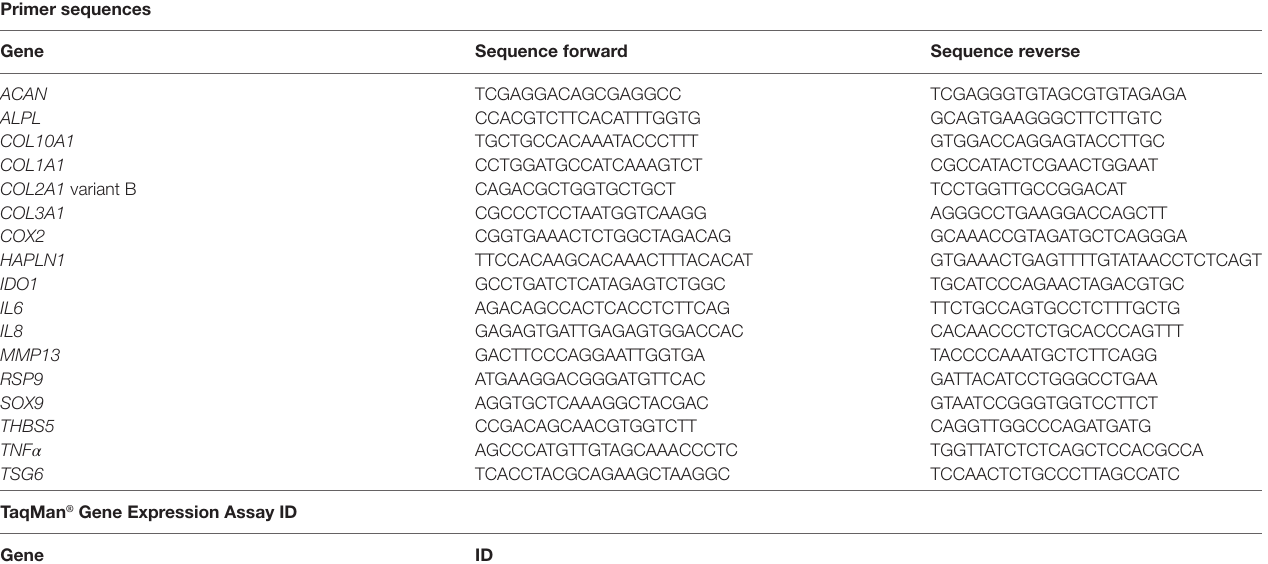
Table 1 | List of primers and assays for PCR analysis and transfection experiments. Primer